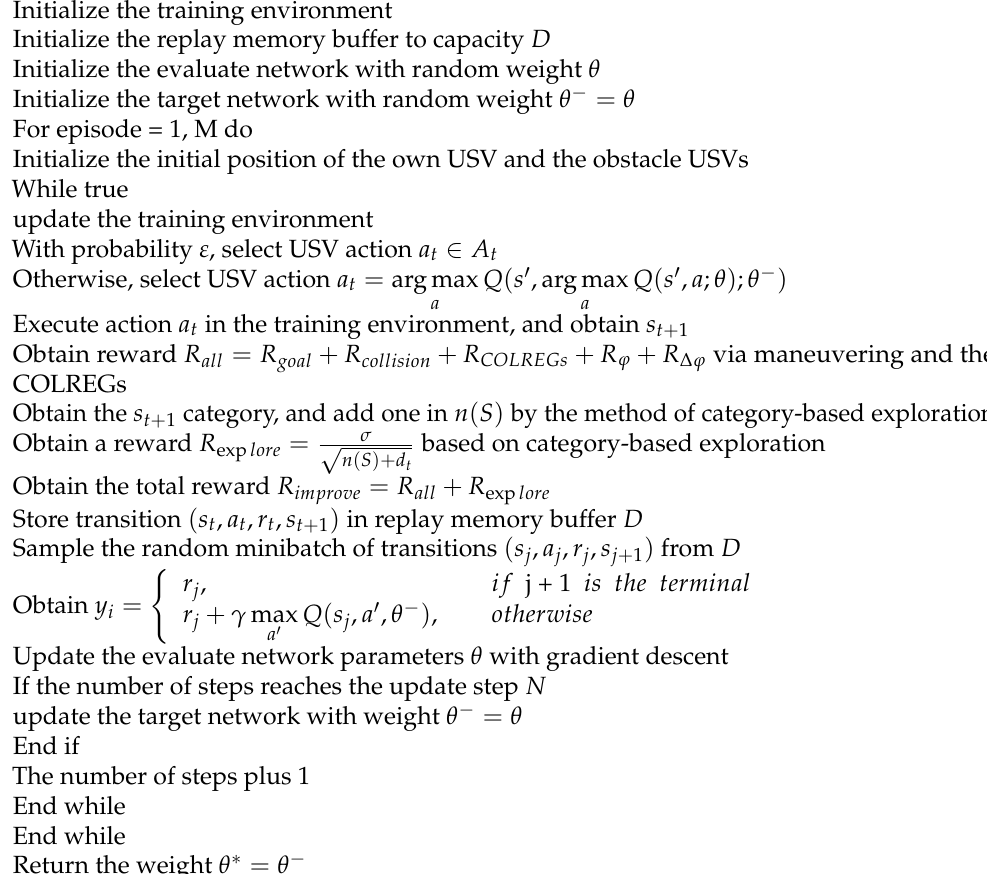
Algorithm 1 RLCA algorithm